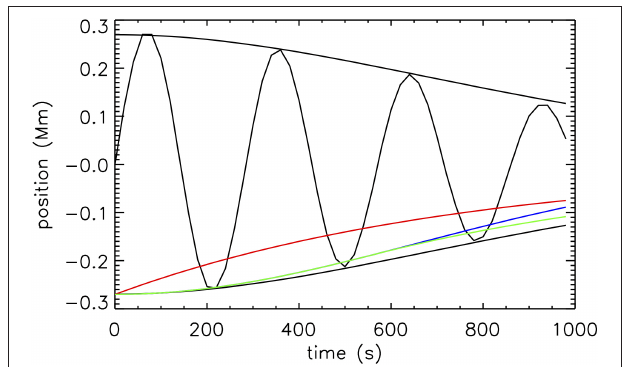
FIGURE 3 | Damping of the kink oscillation after the first applied perturbation. The damping envelopes correspond to the LUT (black), GDP (green), Gaussian (blue), and exponential (red) damping